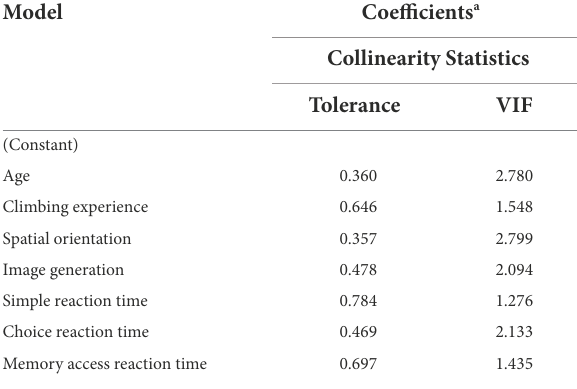
TABLE 4 VIF values for on-sight performance.